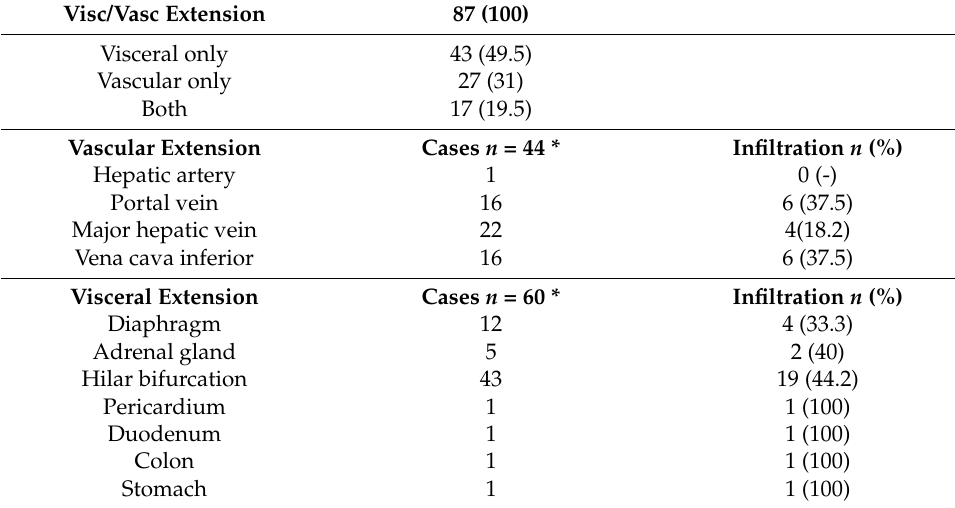
Table 3. Extensions of primary resection ( n